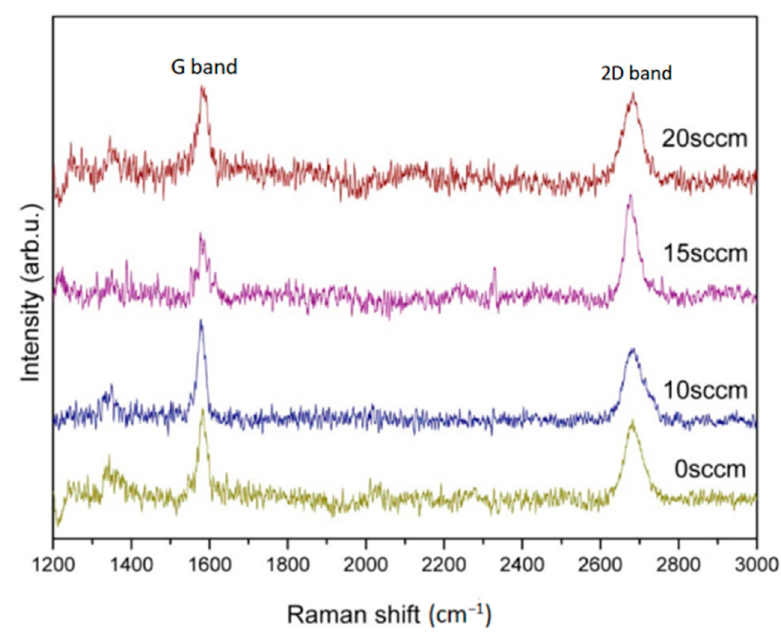
Figure 4. Raman spectra of graphene grown in Ar (20 sccm) with carbon source and various hydrogen flows rate (0, 10, 15, 20 sccm) at 900 ◦ C for 30 min.